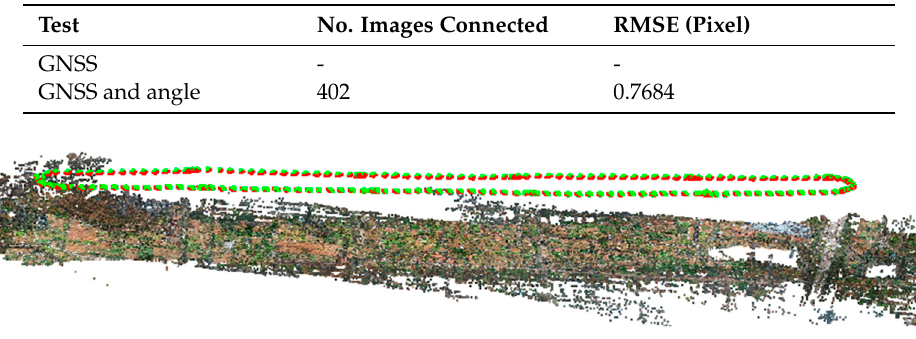
Figure 12. Image orientation of the test site using GNSS and camera mounting angles.